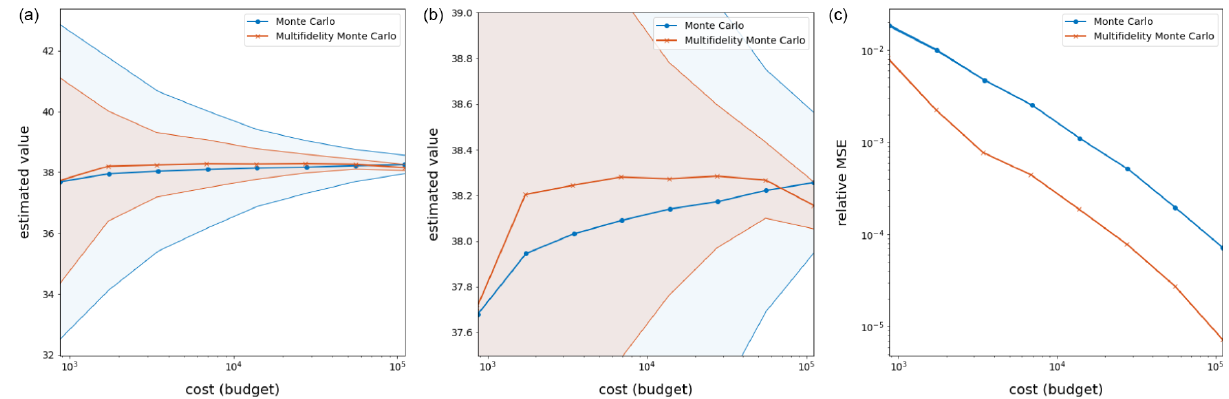
Figure 6. Results over 250 runs of the RSWE system for the Test Case 5 experiment with quantity of interest given by Eq.(16). Shaded regions represent the variance in the MC and MFMC predictions over the 250 runs, which are independent except for the fact that all random sampling employs the same pre-collected (random) set of parameters. Note that the melon region is contained in the blue region, indicating that the MFMC estimator has a smaller standard deviation than the MC estimator.